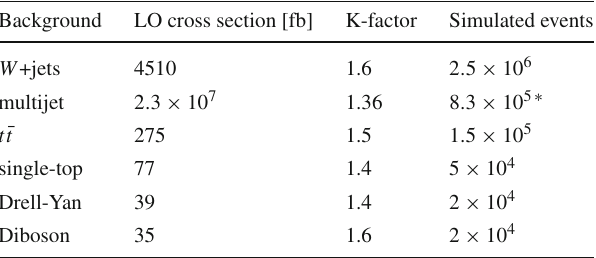
Table 1 SM backgrounds along with the corresponding LO cross sec- tions computed with the conditions of Eq. (1) at a LHC energy of 14 TeV, K-factors extracted from [28], and the number of simulated events. ∗ This number of events has been generated in exclusive bins of H as explained in the Appendix